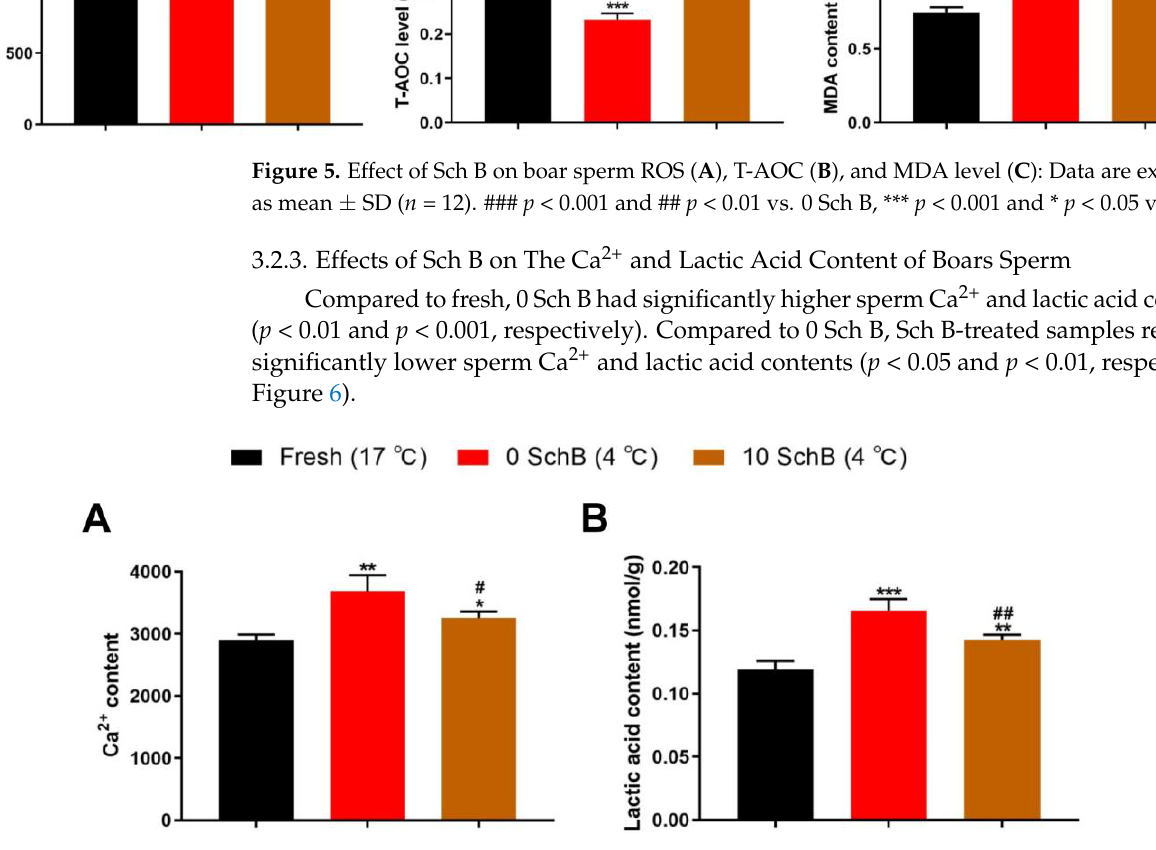
Figure 6. Effects of Sch B on boar sperm Ca 2+ ( A ) and lactic acid ( B ) content: Data are expressed as mean ± SD ( n = 12). ## p < 0.01 and # p < 0.05 vs. 0 Sch B, *** p < 0.001 ** p < 0.01 and * p < 0.05 vs. fresh.